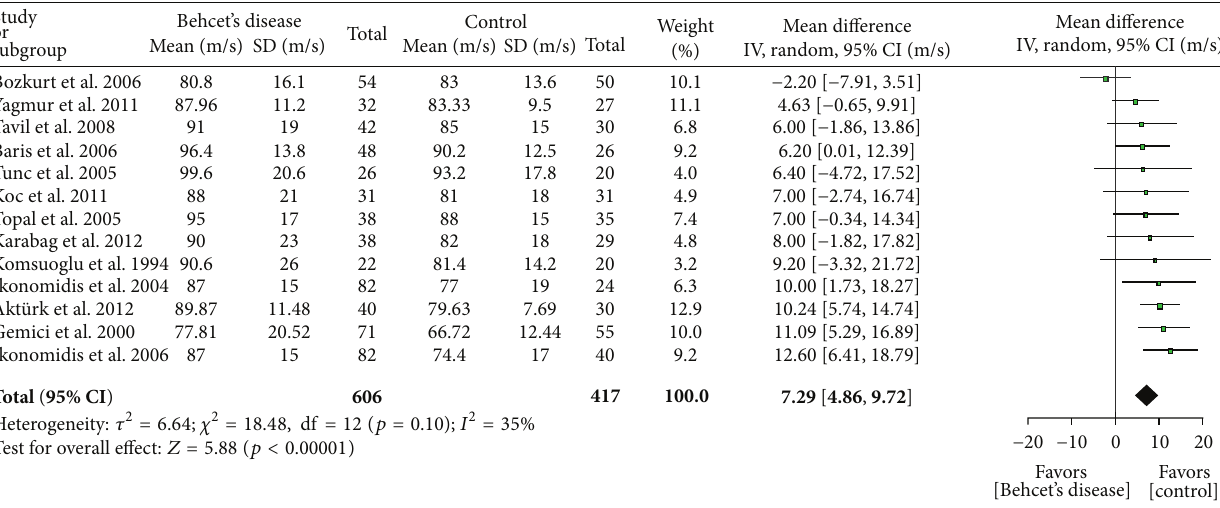
Figure 2: Isovolumetric relaxation time comparison between patients with Behcet’s disease and controls.